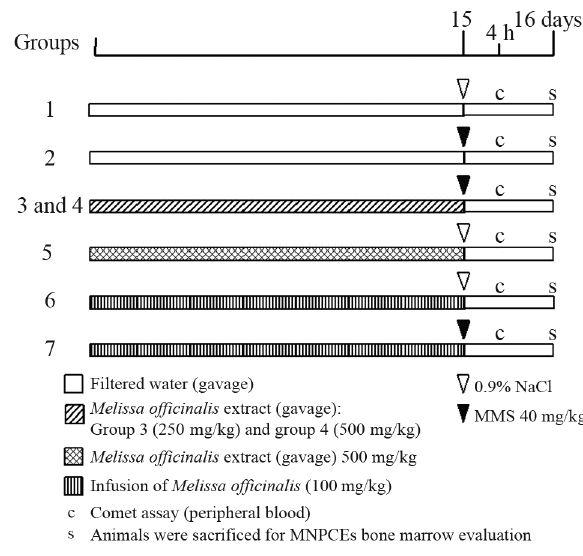
Figure 1 - The antimutagenicity and antigenotoxicity of an Melissa officinalis extract in mutagen-induced